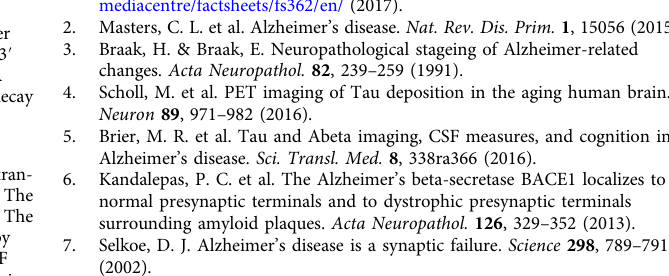
algorithm on normalized cell-type-speci fi c count data. In this approach, we used a gene signature matrix (involving 903 cell-speci fi c marker genes) derived from single cell RNA-seq measures in adult human brain cells (signature matrix; 74 source 75 ). CIBERSORT 68 was run (100 permutations), and values were used for